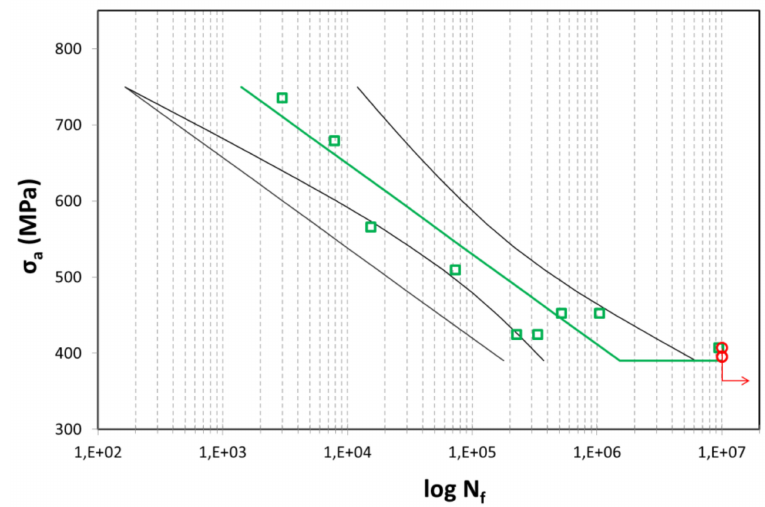
Figure 8. S–N curve for the sample after Conform SPD one pass + rotary swaging (80% area reduction).